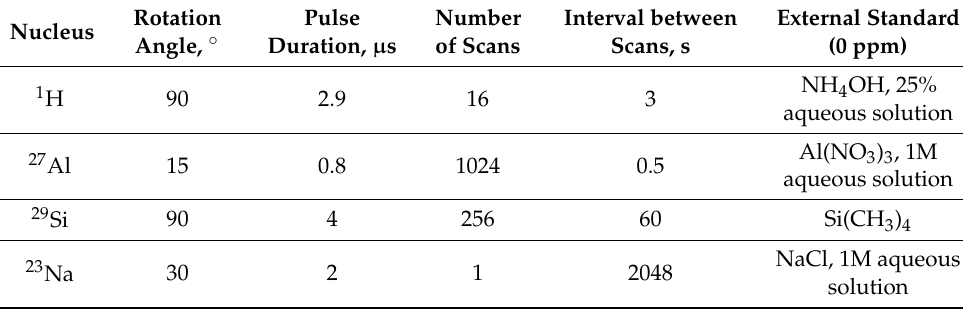
Table 5. The conditions for the conduction of solid-state NMR